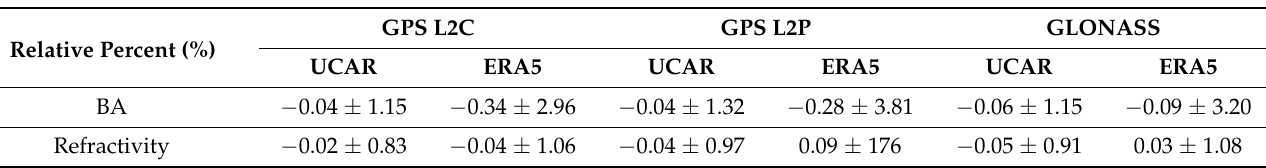
Table 2. Mean difference and standard deviation of bending angle and refractivity comparison with UCAR and ERA5 at 10–35